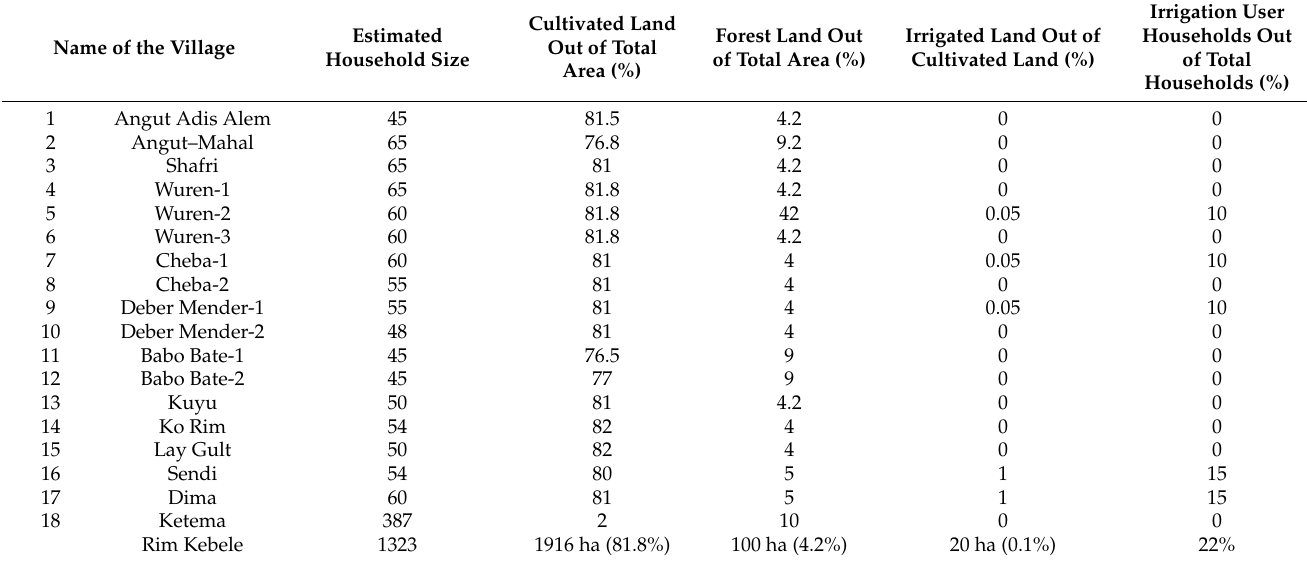
Table A1. Information about Rim Kebele villages, household sizes, and cultivated area.